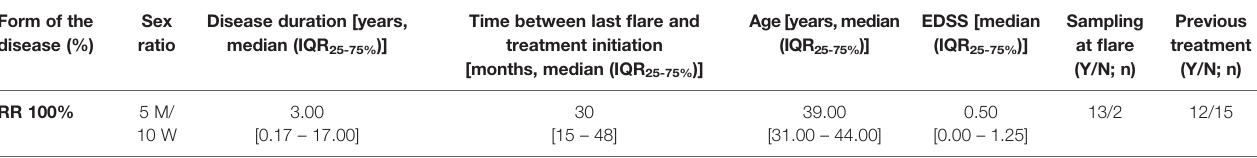
TABLE 1 | Demographical and clinical characteristics of the patients at sampling. Form of the Sex disease (%)